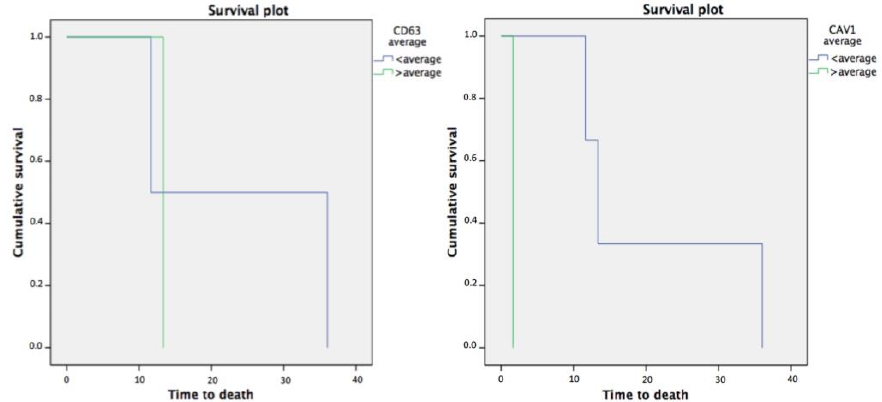
Figure 4. The graph shows the cumulative survival of patients according to their average levels of exosomes with CD-63 (left) and CAV-1 (right) after resective surgery.